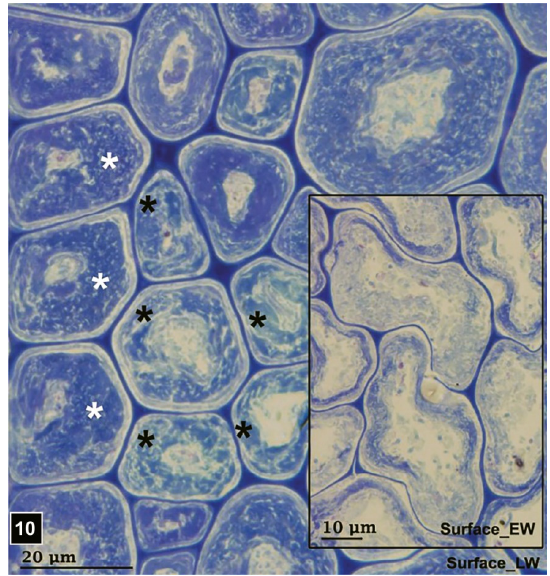
Figure 10. LM micrographs of the outer parts (3 cm from the surface) of Daebudo-ship. Section stained with toluidine blue. Latewood (LW) and earlywood (EW) tracheids (inset) contain a granular residue in regions where the secondary cell wall has been degraded. Note the two distinct toluidine blue staining patterns in the LW tracheids (white vs. black asterisks), reflecting compositional variability. The images are reproduced from Cha et al. 2021. IAWA J.